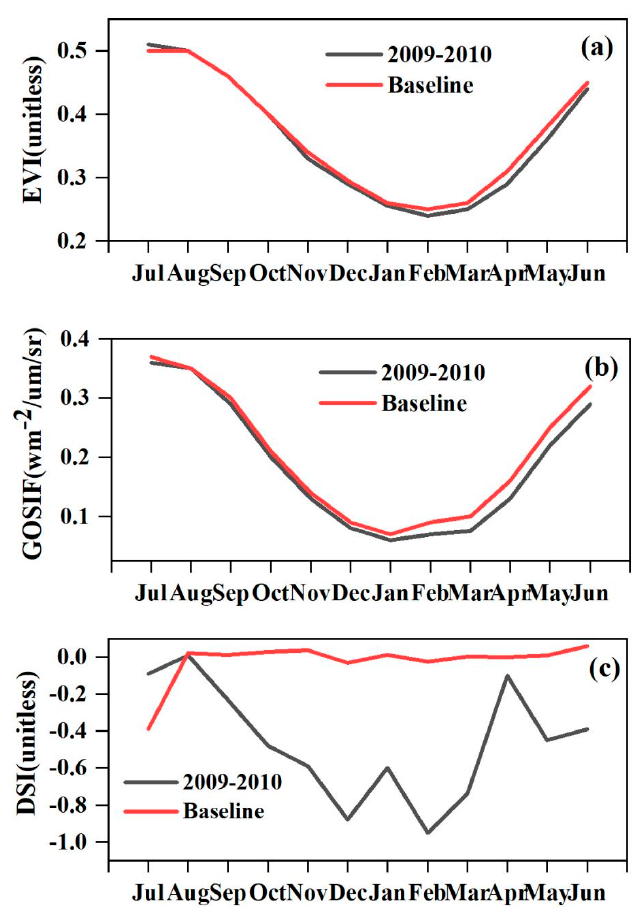
Figure 5. Regional mean interannual variation in ( a ) EVI, ( b ) SIF and ( c ) DSI in three provinces in the southwest from July 2009 to June 2010. (The red line shows the monthly average from July 2009 to June 2010, and the black line shows the multiyear monthly average from 2000 to 2019 (DSI is from 2000 to